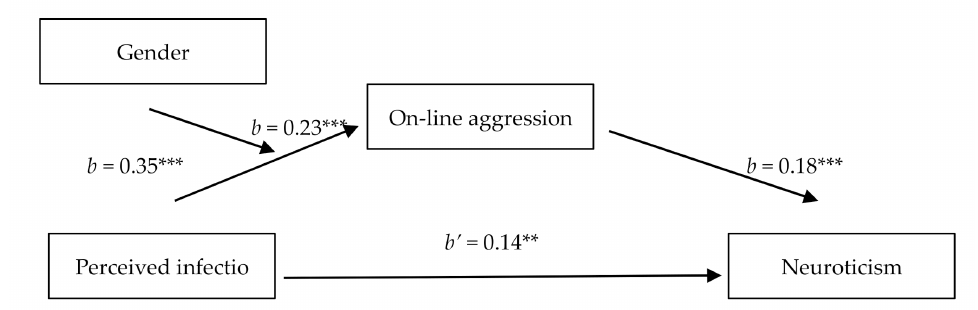
Figure 3. Mediation model in Study 1. ** p < 0.01. *** p <